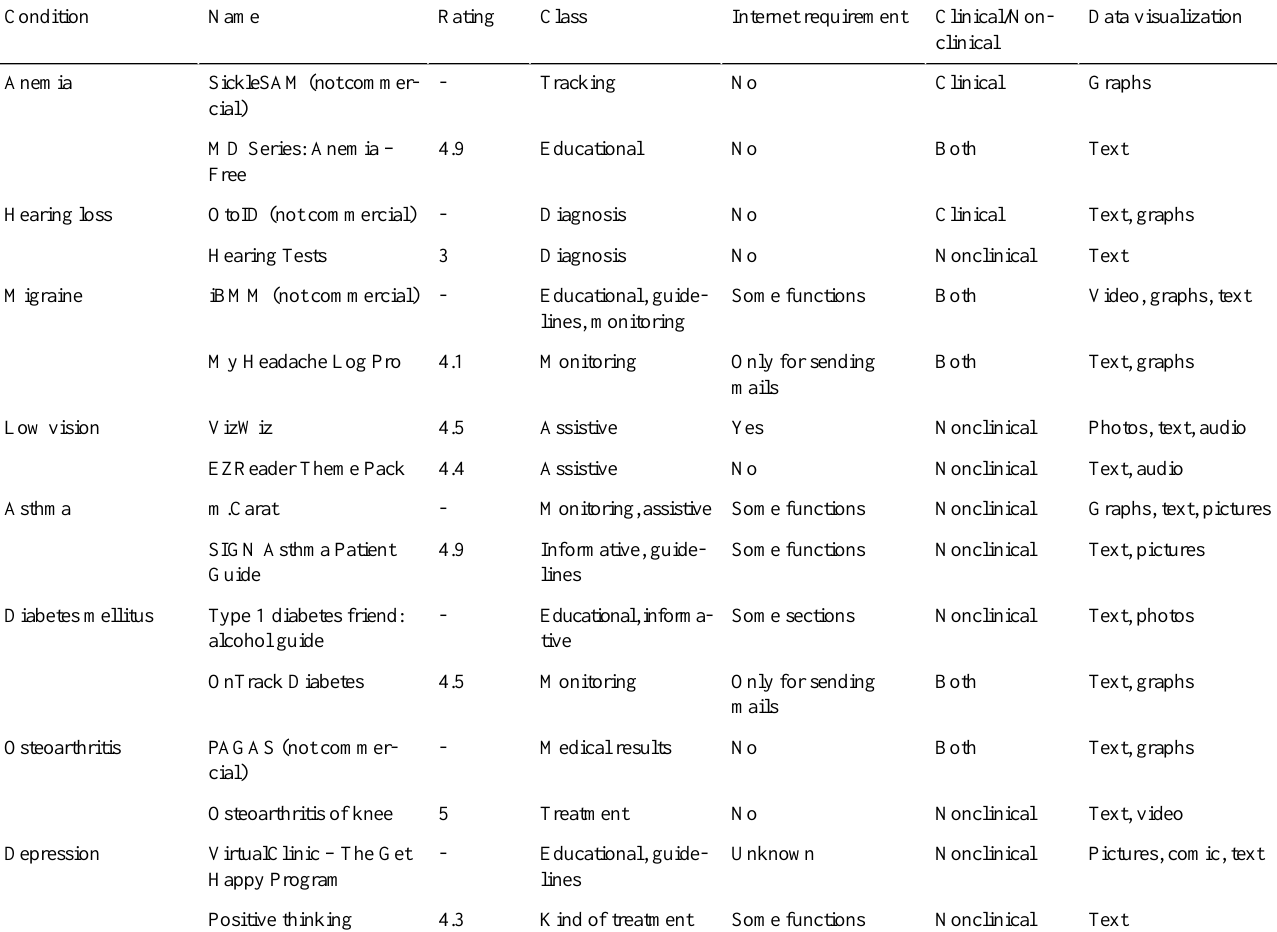
Table 4. Analysis of features (Part 1) of the selected